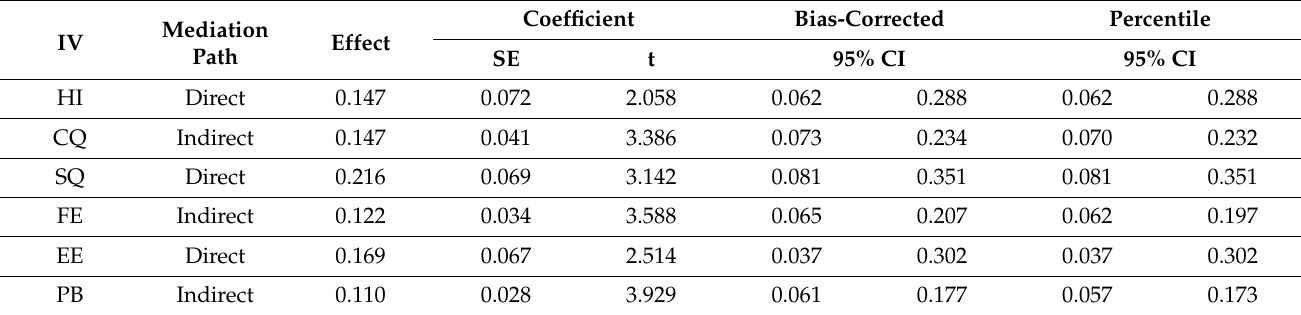
Table 7. The mediating roles of functional experiences in the relationships between system character- istics and citizenship behavior.